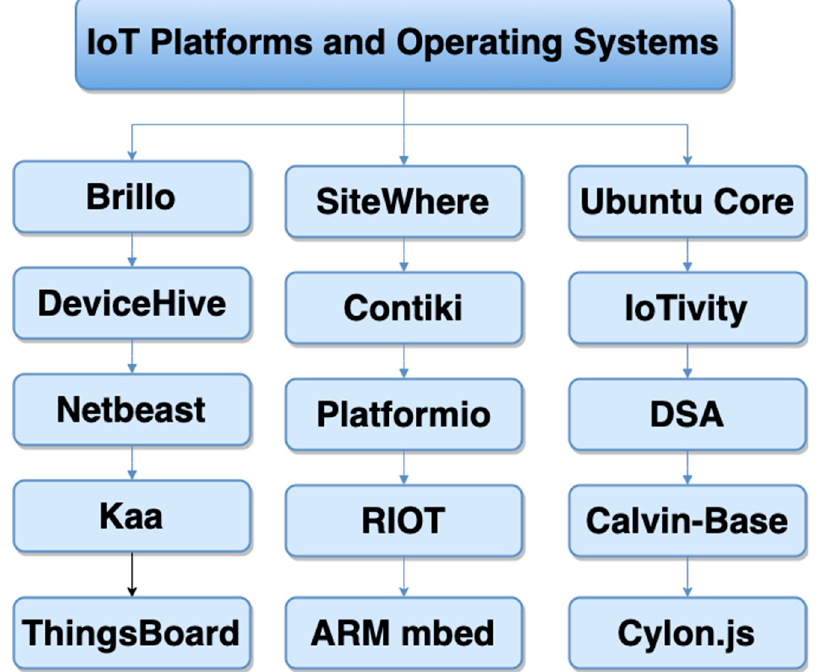
Figure 3. IoT platforms and operating systems.